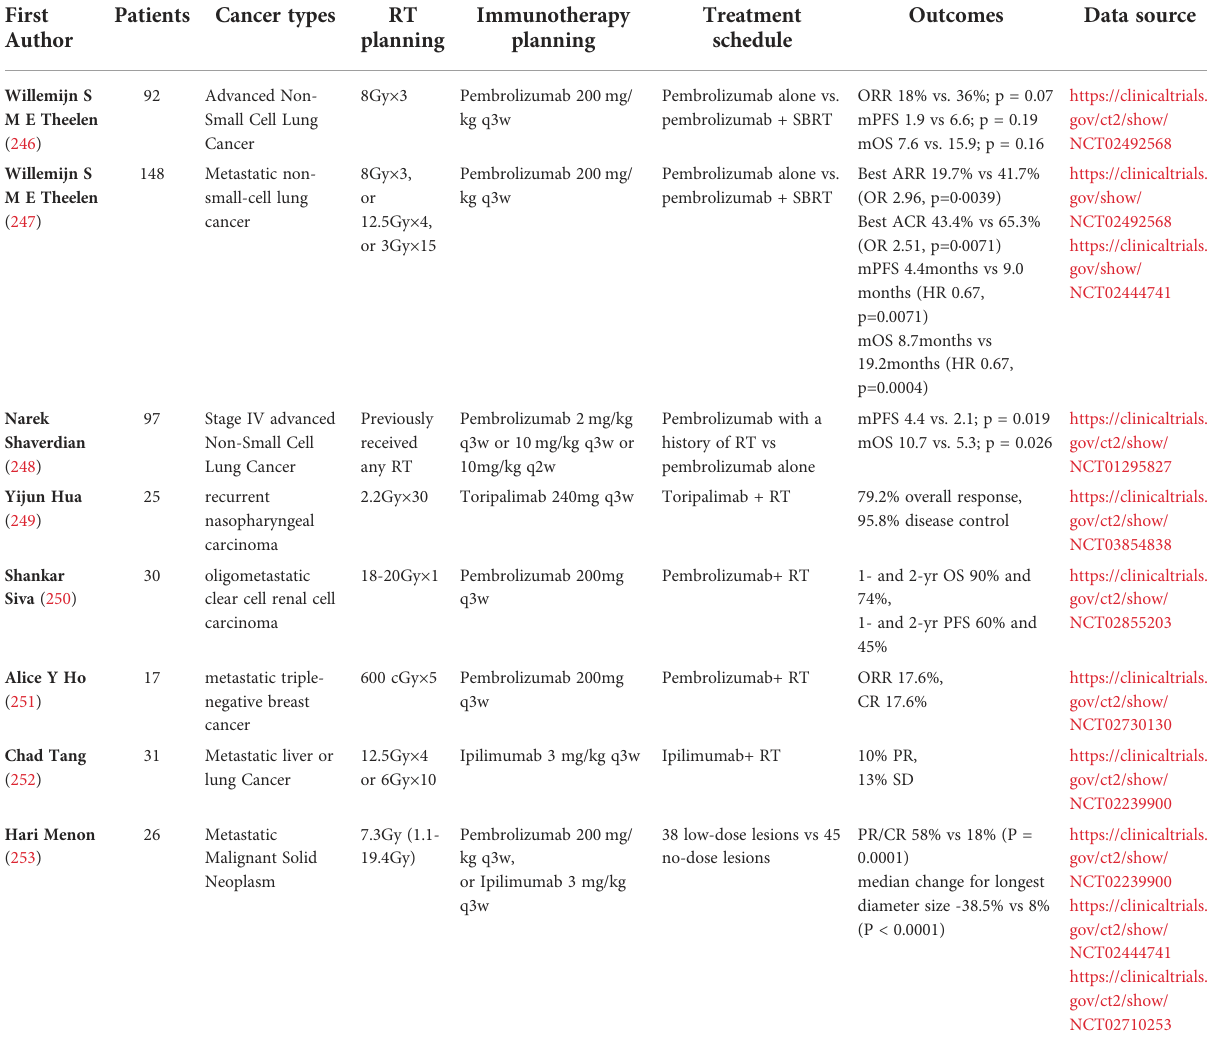
TABLE 2 Landmark clinical trials of RT combined with immunotherapy for the treatment of